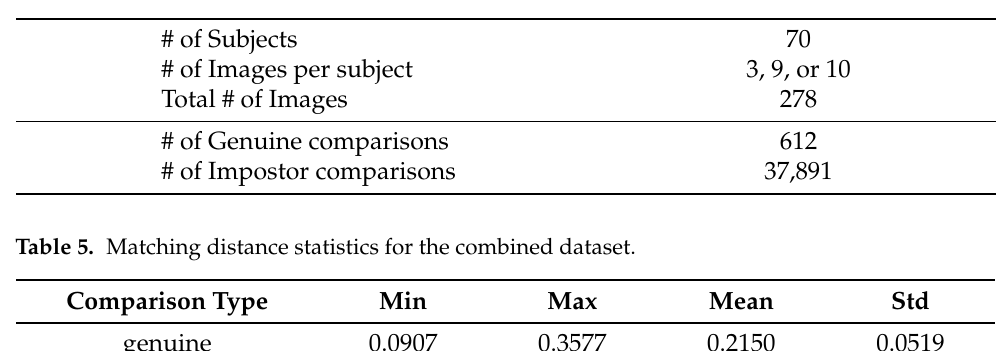
Table 4. Comparison (matching) summary for the combined dataset.